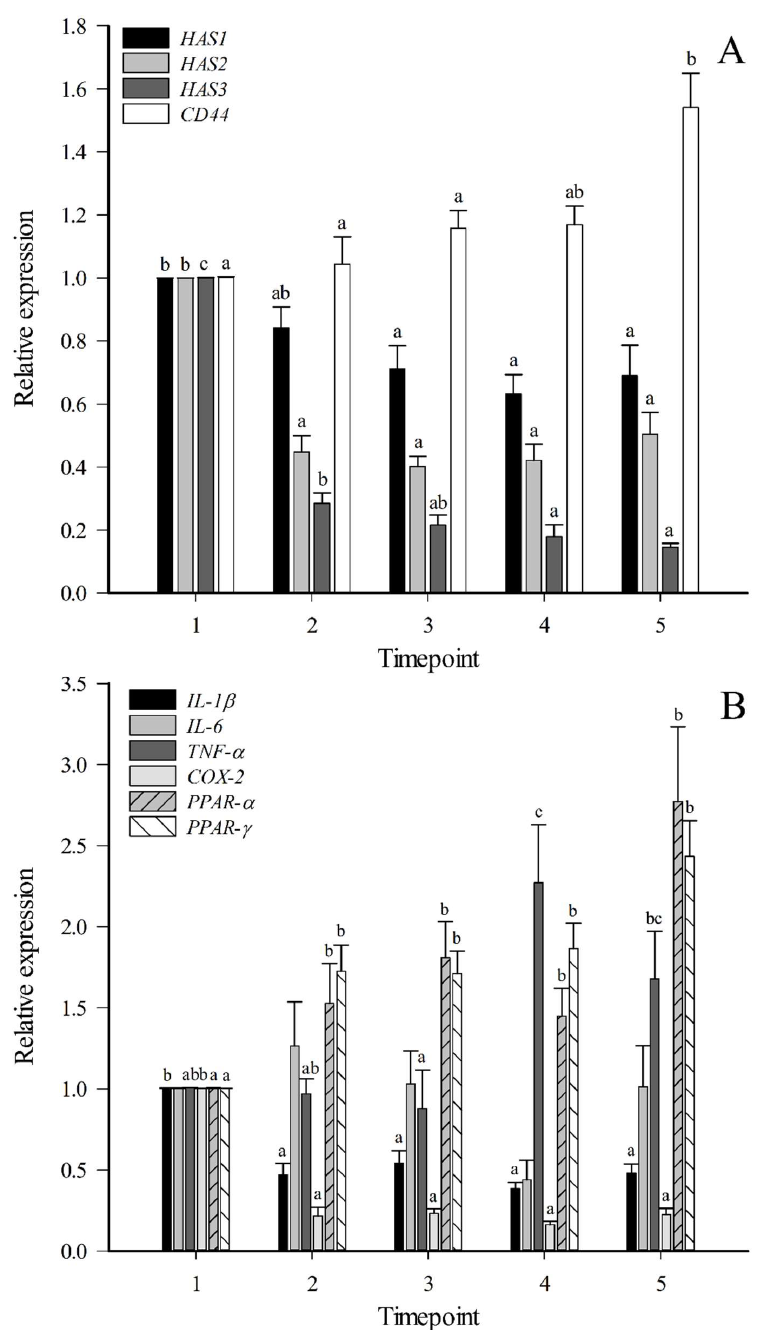
Figure 5. Temporal changes in the expression of selected genes in fibroblast-like synoviocytes (mean + SE). Real-time quantitative PCR was used to determine the ratio of the mRNA expression of the genes of interest relative to the control gene ribosomal protein lateral stalk subunit P0. Panel ( A ) represents HAS1–3 = hyaluronan synthase 1–3 and CD44 = cluster of differentiation 44. Panel ( B ) shows IL-1β/6 = interleukin-1 β /6, TNF-α = tumor necrosis factor α , COX-2 = cyclooxygenase 2, and PPAR-α/γ = peroxisome proliferator-activated receptor α / γ . Timepoint 1 = lag phase, timepoints 2– 3 = proliferating cells, timepoints 4–5 = high-density cells. Means with dissimilar letters indicate significant differences between timepoints (Kruskal–Wallis ANOVA, p < 0.05).